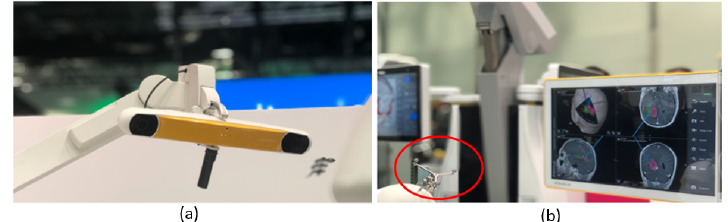
Figure 1. Images of standard setup with indirect patient tracking ( [18]). ( a ) The stereoscopic infrared camera setup for tracking the DRF (dynamic reference frame). ( b ) The DRF (in the red circle) and the monitor displaying the position on a CT patient